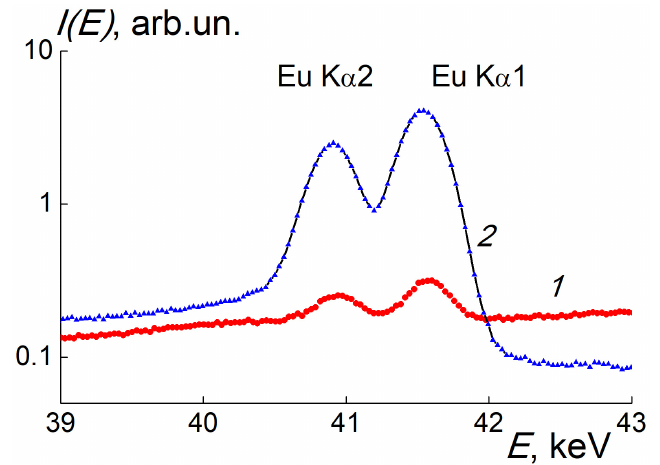
Figure 11. XRF@241Am spectra for the SEu3 (1) and the reference sample (2). The lines Eu K α 2 and Eu K α 1 are marked. Comparison of peaks amplitudes for the probes (1,2) allowed us to find the Eu concentration in the SEu3 sample enriched with diamonds.